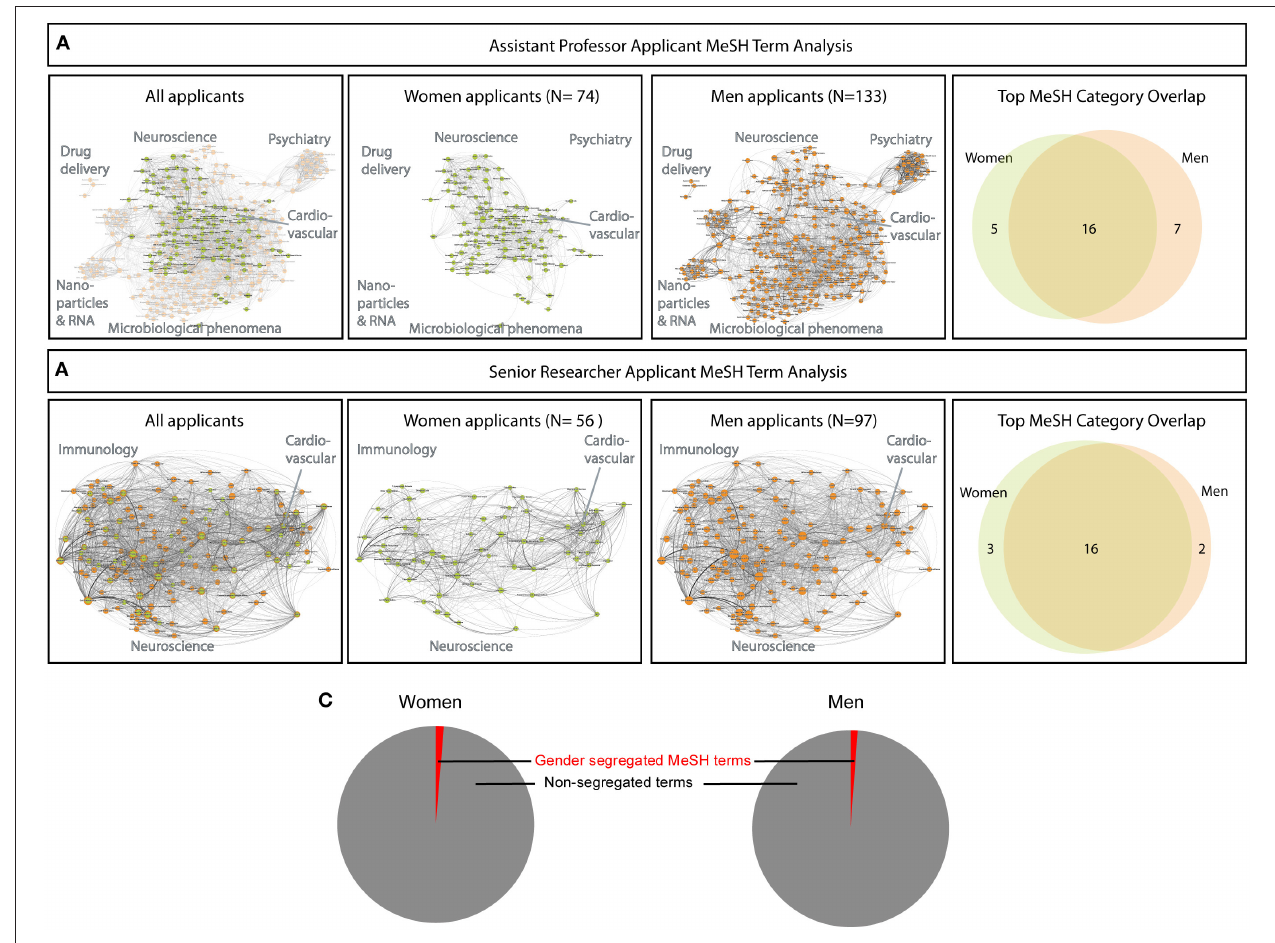
FIGURE 2 | Analysis of field representation among men and women applicants using MeSH (medical subject headings) term analysis. (A) Applicants for assistant professor positions are more diverse and encompass 207 applicants (74 women and 133 men). Field representation is not obviously skewed by biased fields such as cardiovascular medicine, which is represented by MeSH terms among both men and women. There is a high degree of overlap in MeSH terms among men and women applicants as seen in the Venn diagram at right. (B) Men and women applicants for Senior Researcher positions were fewer in total (153), are highly similar, and show near-complete overlap in MeSH terms, as seen in the Venn diagram at the far right. (C) Analysis of MeSH terms for gender-segregated topics revealed a very small fraction of gender-segregated MeSH terms among men (1.2%) or women (1.3%) applicants.